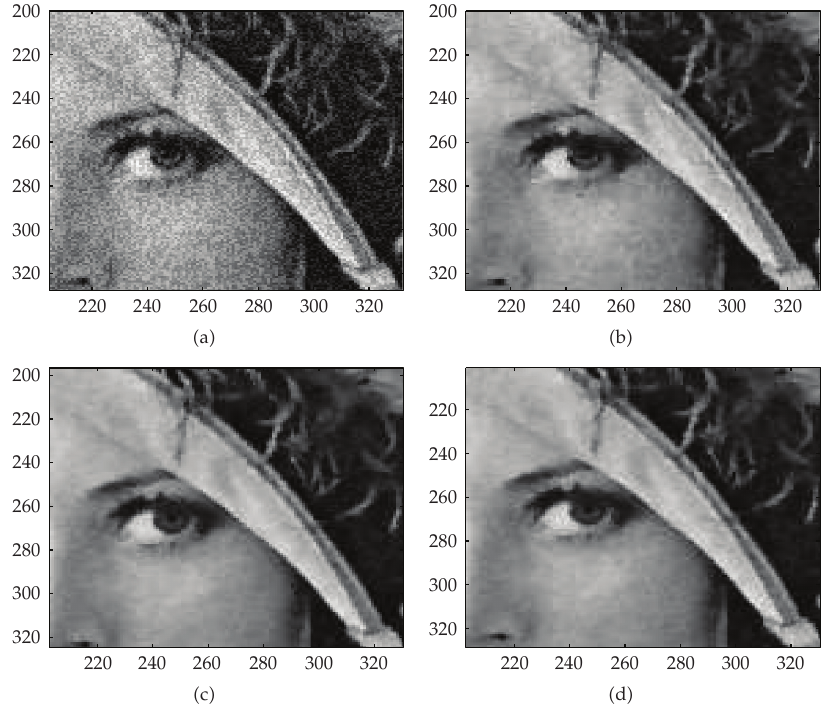
Figure 2: (cid:7) a (cid:8) zoom of the noisy Lena image (cid:7) σ (cid:10) 20 (cid:8) , (cid:7) b (cid:8) zoom of the restored Lena image using the nonlinear di ff usion method, (cid:7) c (cid:8) zoom of the restored Lena image using topological gradient approach with the isotropic algorithm, and (cid:7) d (cid:8) zoom of the restored Lena image using topological gradient approach with the anisotropic